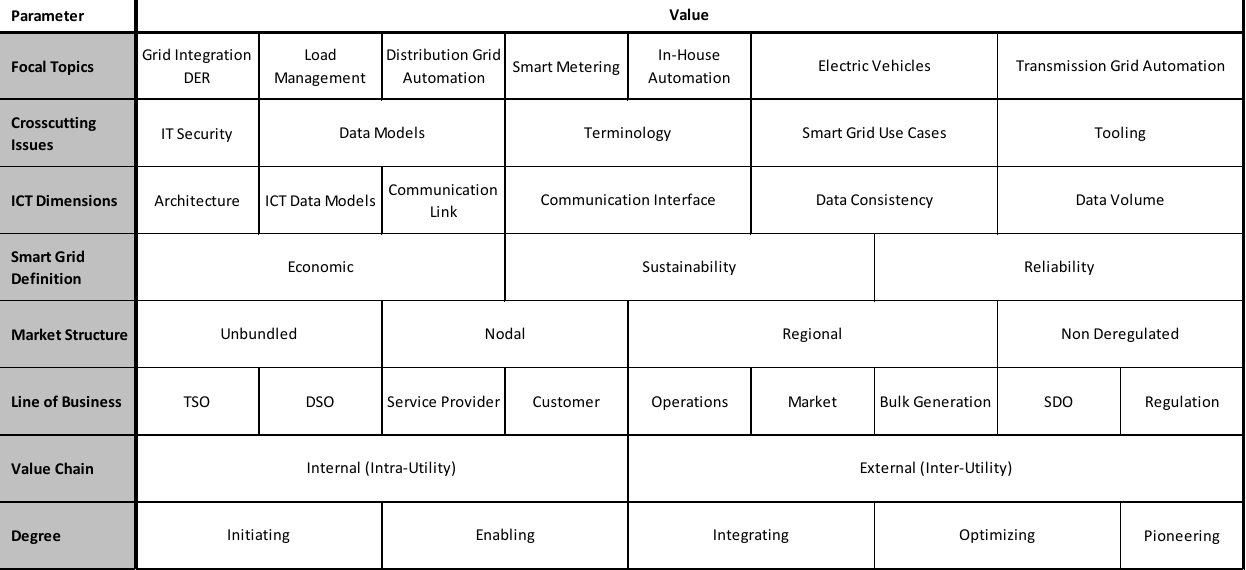
Figure 4 . Configuration parameter for the use of the